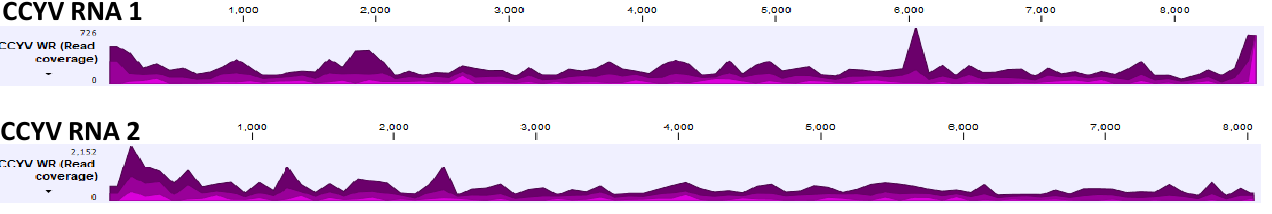
Figure 2. Read coverage maps of cucurbit chlorotic yellows virus (CCYV) detected by high through- put sequencing of small RNAs of symptomatic wild radish. Scaled genome positions of the virus are shown above the histograms and the Y-axis represents the coverage in the number of reads. Within the specified aggregation bucket from top to bottom, the colors mean: the maximum coverage value (read count), the average coverage value, and the minimum coverage value.